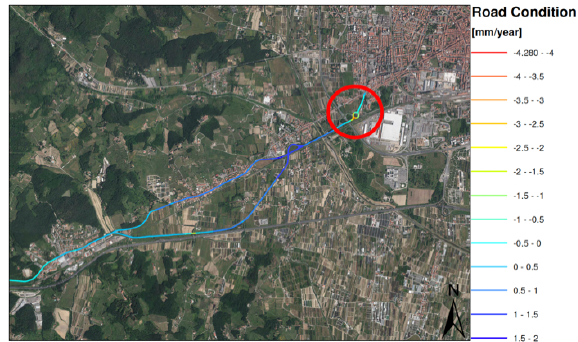
Figure 4. Road average yearly displacement